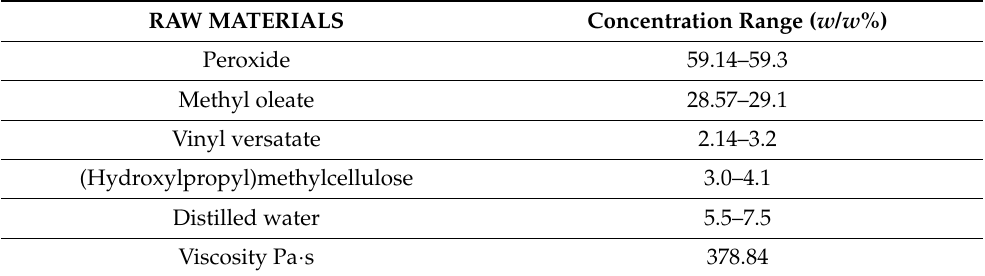
Table 2. Formulation of methyl oleate paste as cross-linking agent for unsaturated polyester resins.